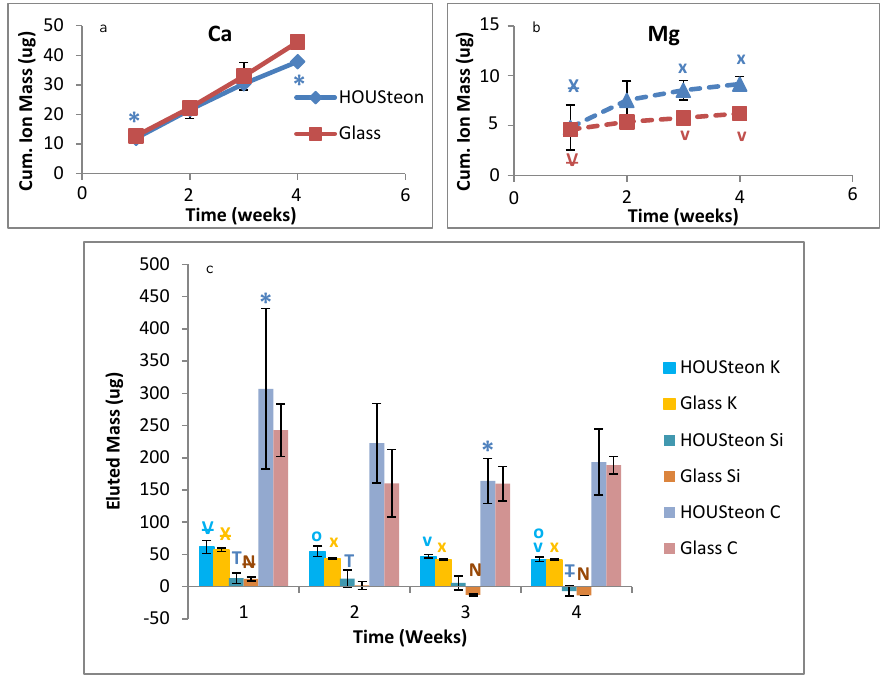
Figure 10. ICP-OES of the cumulative ion mass eluted of ( a ) calcium and ( b ) magnesium. ( c ) The eluted mass of potassium, silicon, and carbon. *, V, X, T, N, and O denote statistical significance, with strikethrough indicating parent significance to respective letters ( p <